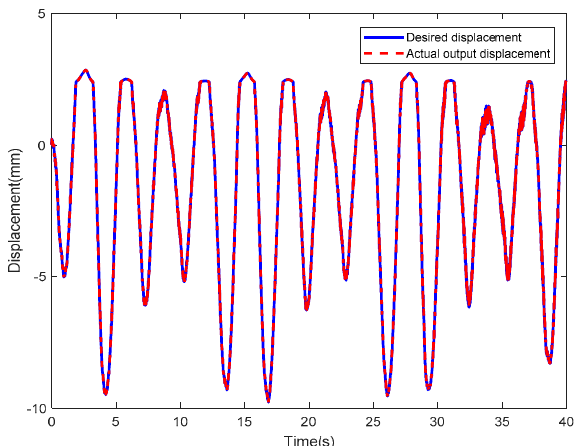
Figure 44. Control results of hybrid PID feedback controller. Figure 43. Control results of hybrid PID feedback controller. Figure 43. Control results of hybrid PID feedback controller.